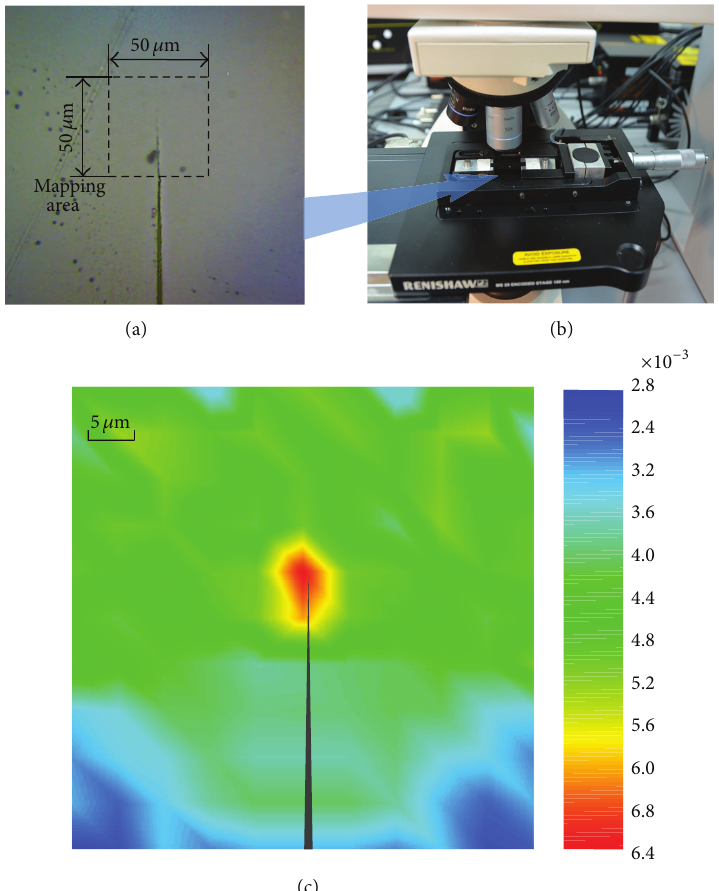
Figure 8: The experiment on the mode I crack. (a) Experimental system, (b) the image of the sample and Raman mapping region, (c) the around the crack distribution of 𝜀 x